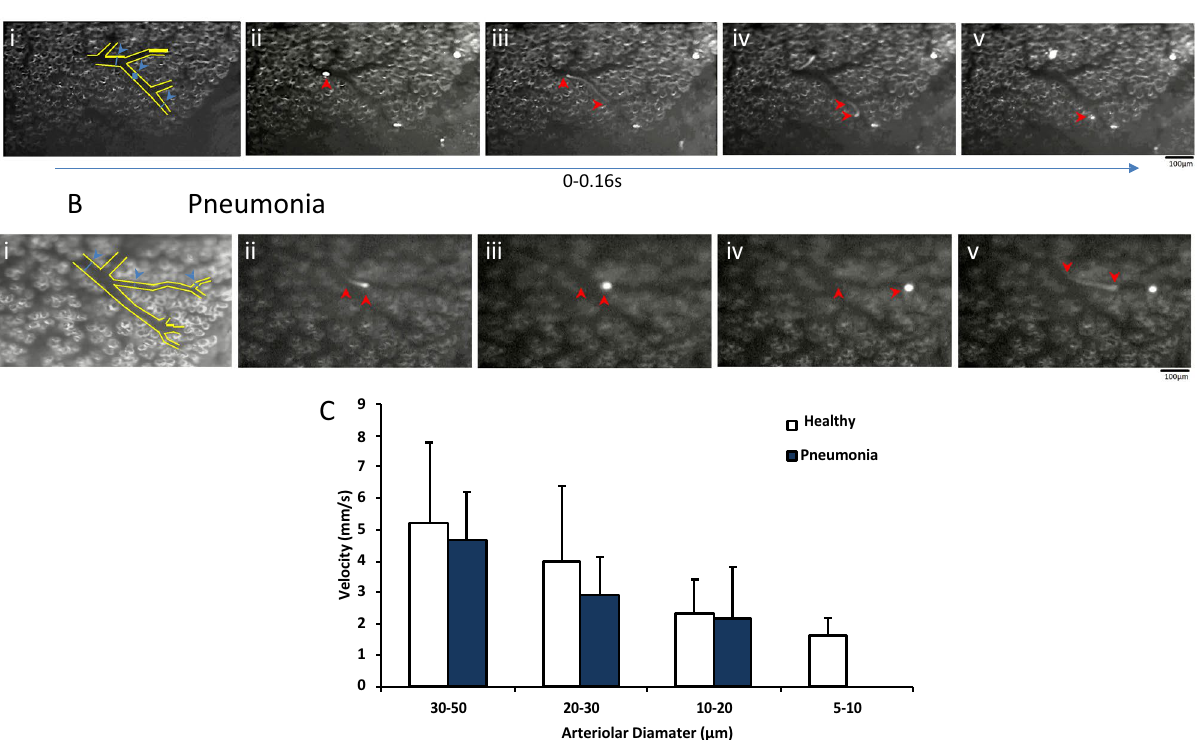
Figure 3. Real-time Intra-vital recording of MSC accumulation in the murine lung microvasculature allowed for measurements of velocity in healthy ( A ) and E. coli infected lung ( B ). Velocities of individual MSCs (movement indicated by red arrows, A, B, Panels ii–v) were measured in different pulmonary vessel diameters (Blue arrows, A , B , Panel i) Quantitative analysis showed that there was no significant differences in MSC velocities in different vessel diameters between healthy and pneumonia mouse models ( C ). MSC: Mesenchymal Stem Cell; Columns represent mean + SD (n = 4–13 from 6 separate